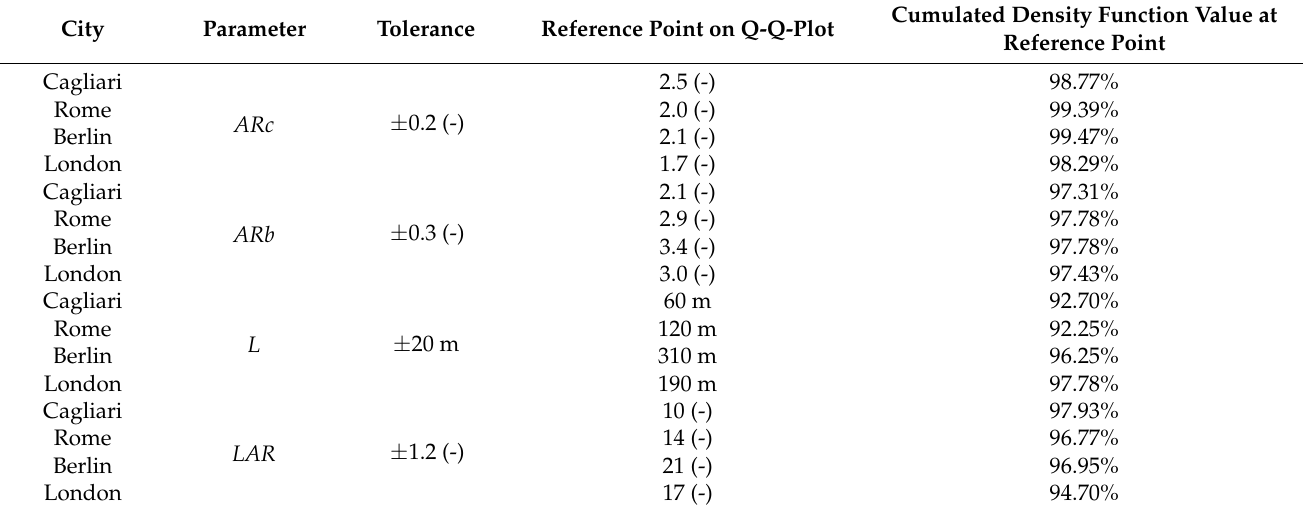
Table 3. Cumulated density function at the reference point (i.e., the last point where data are still included in the tolerance interval) for the various